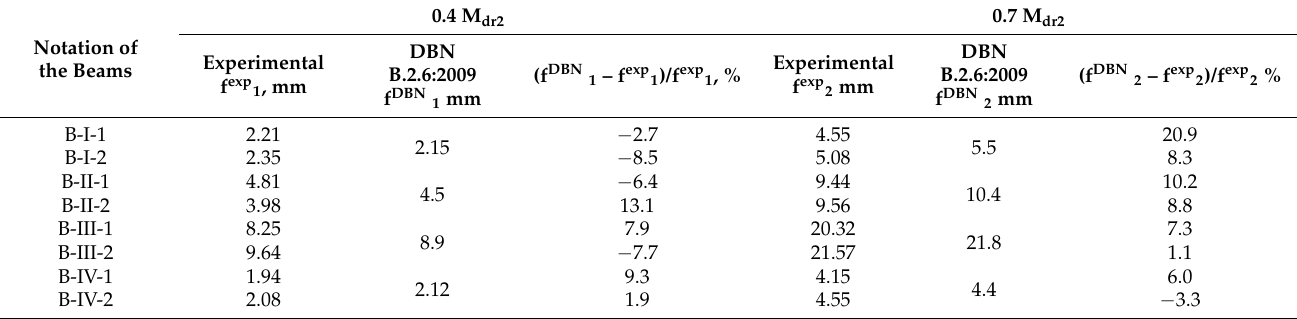
Table 7. Experimental and theoretical values of deflections of test beams.